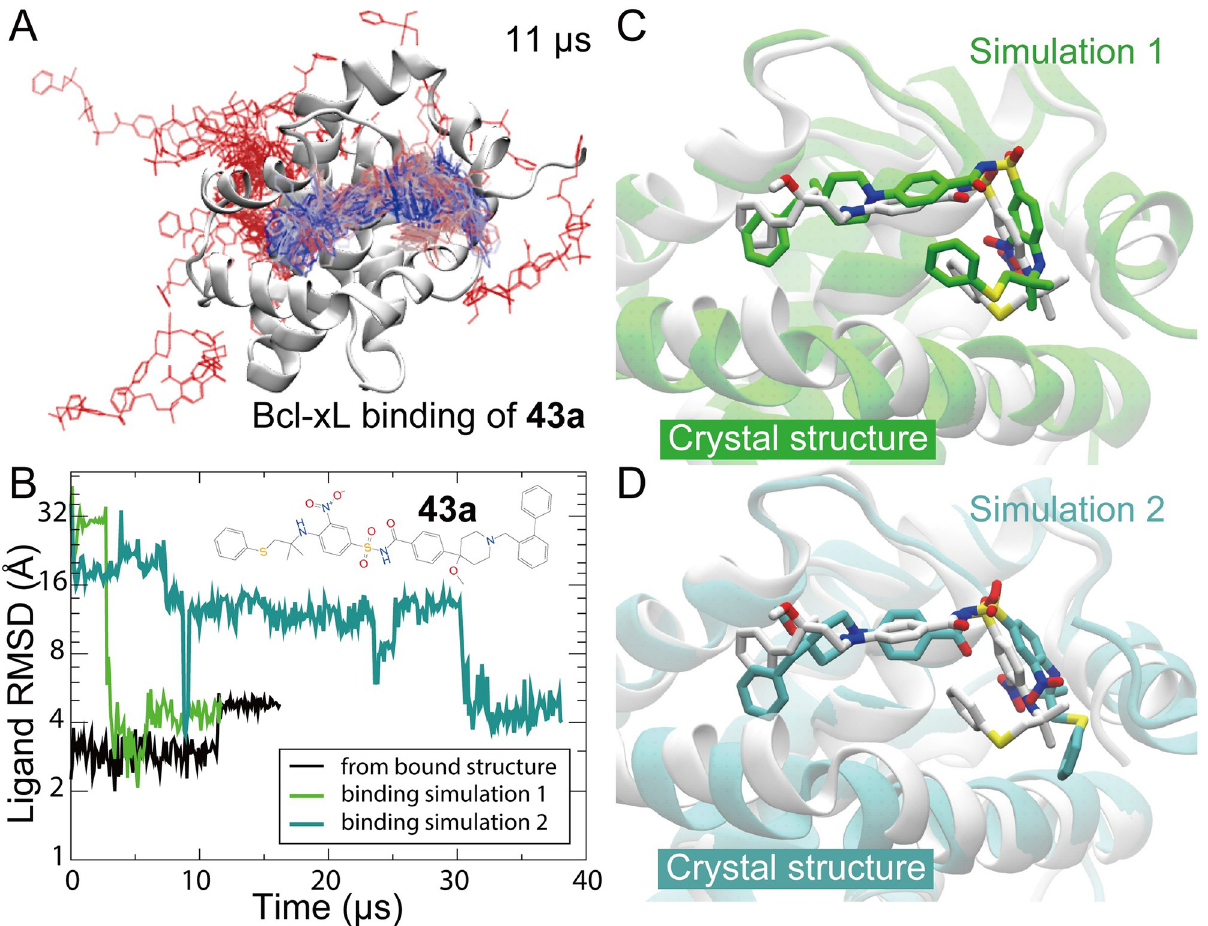
Fig 6. Compound 43a binding to Bcl-xL. (A) Positions of the small molecule in an 11- μ s simulation (Simulation 1) in which it reached the native binding pose. Simulation time is color-coded from red, to gray, to blue. (B) The RMSD of the small molecule with respect to the crystal structure (PDB 2O2M) in the binding processes of Simulations 1 (green) and 2 (cyan). Also shown is the RMSD of the small molecule in a simulation starting from the bound structure. All three simulations eventually settled at the same RMSD region. (C) and (D) The binding poses generated by Simulations 1 and 2, respectively, compared with the crystal structure. Note that simulation-generated binding poses are very similar but not identical to the crystal structure. The relatively minor discrepancies may be attributable to the force field for the small molecule.